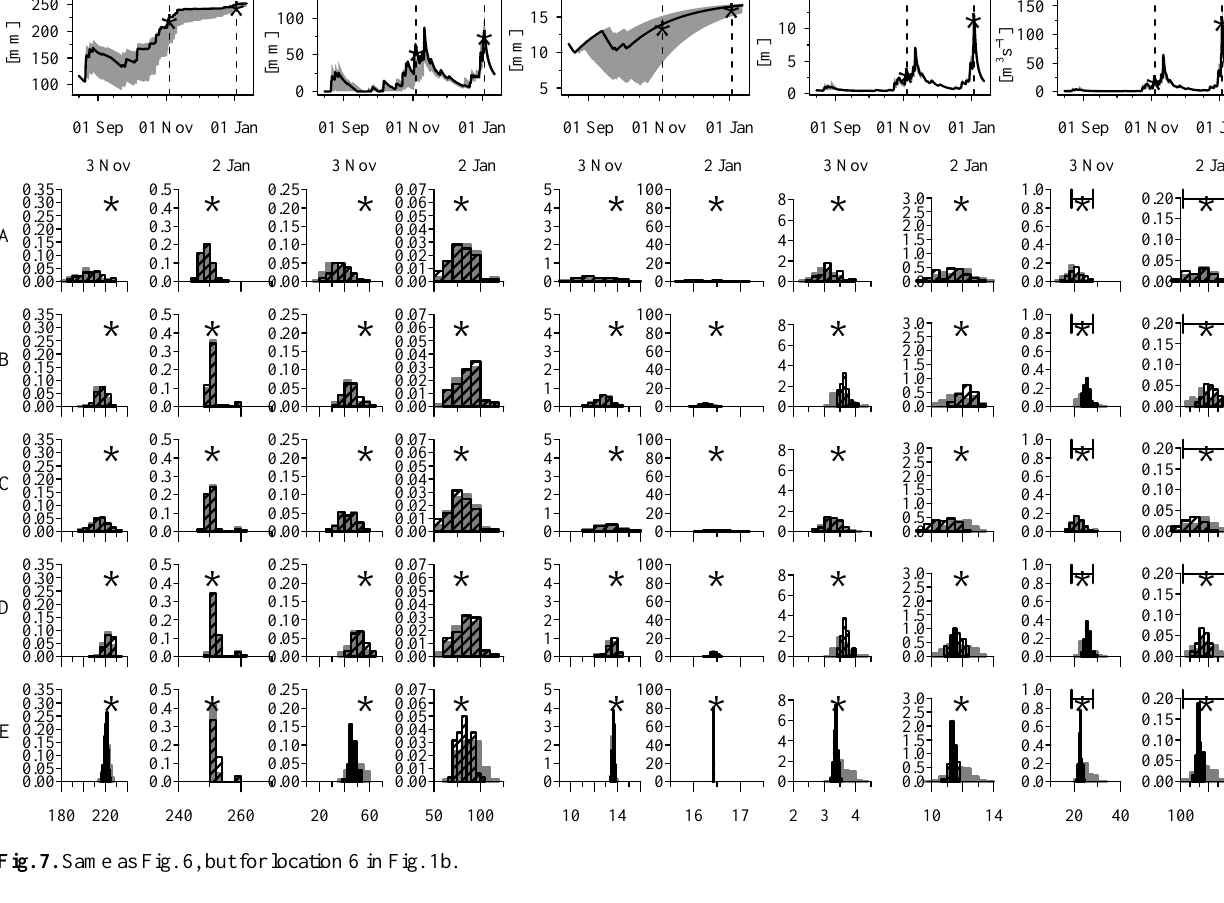
Fig. 7. Same as Fig. 6, but for location 6 in Fig. 1b.